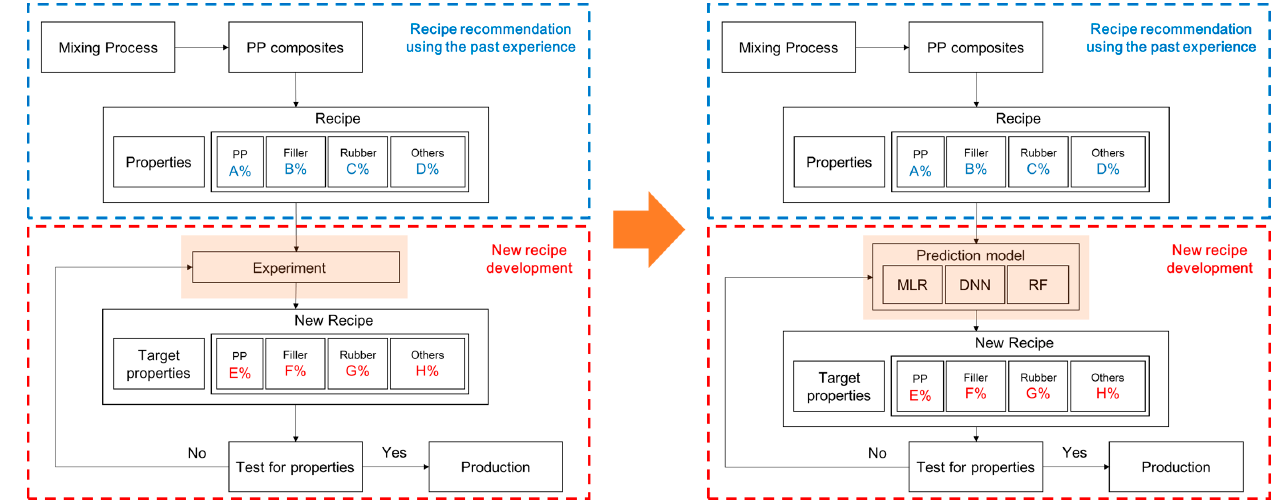
Figure 1. Flowcharts for developing recipes for polypropylene (PP) composites.